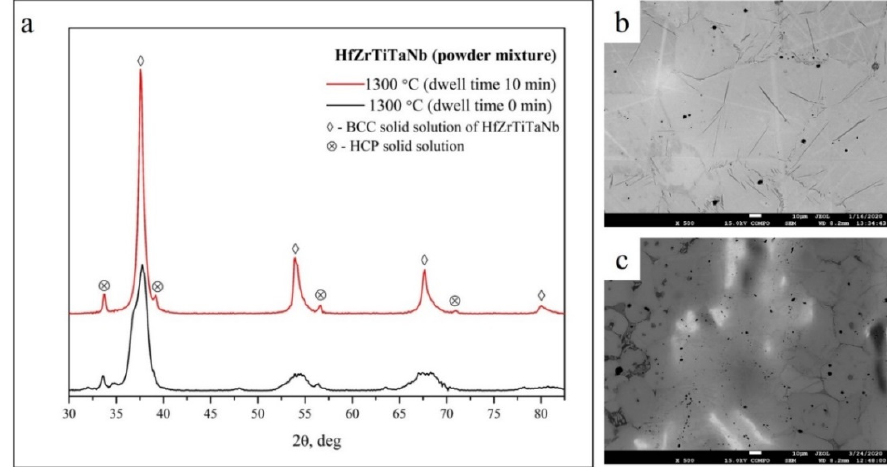
Figure 3. XRD patterns and SEM images of bulk HfTaTiNbZr specimens sintered at 1300 °C for τ = 10 ( a,b ) and 0 min ( a,c ).